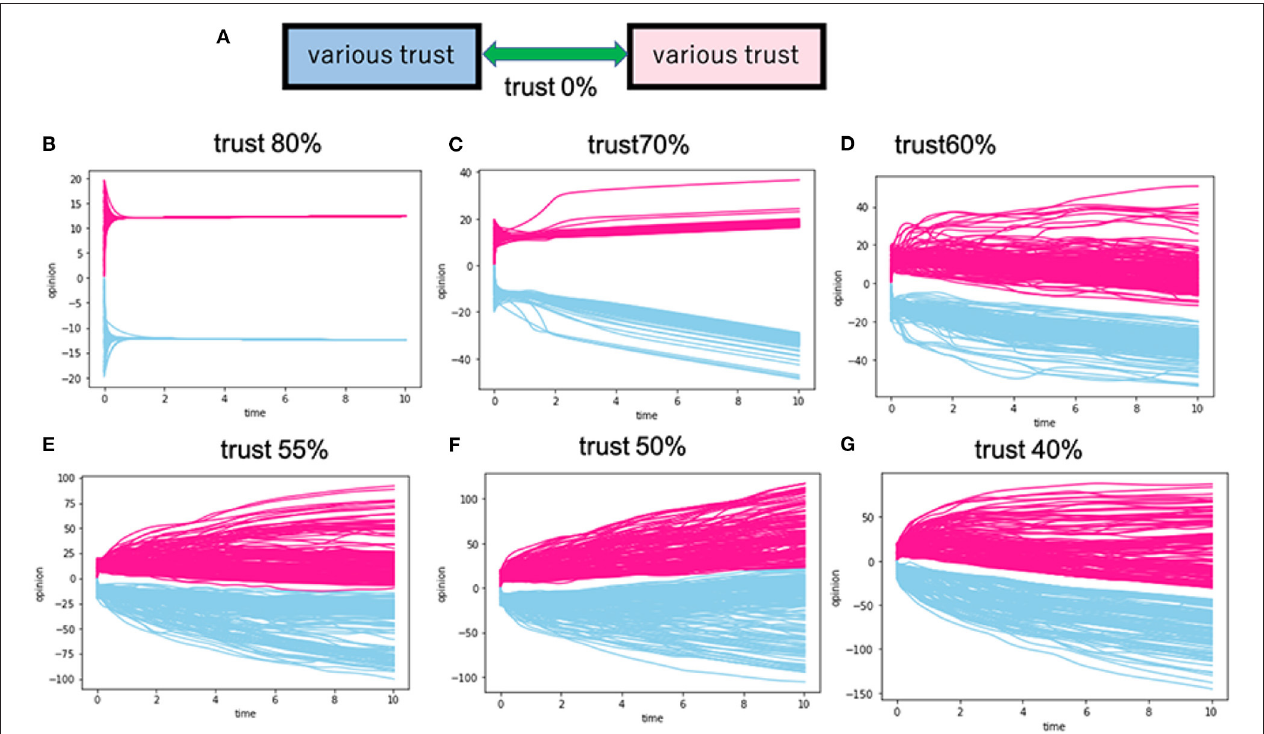
FIGURE 5 | Calculation for the cases of no intergroup trusts between group A and group B. (A) Is the schematic view of this model. (B–G) Correspond to the various intragroup trusts. The red lines in the figures indicate the opinion trajectories of group A, and the blue lines are those of group B. For instance, the trust of 80% in (B) means that 80% of the intragroup trusts ( D ij ) for A and B are positive